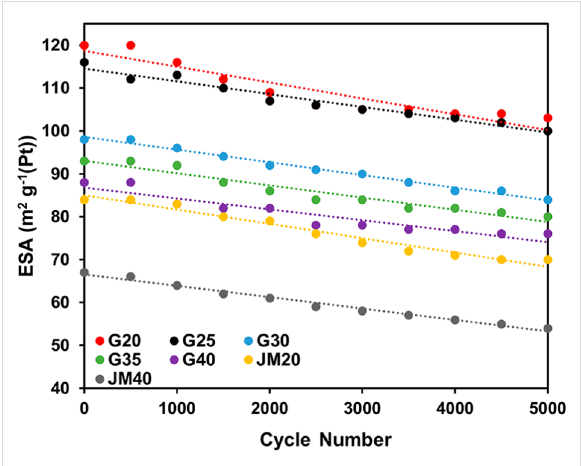
Figure 7: Dependence of the ESA of the catalysts on the number of stress test cycles.